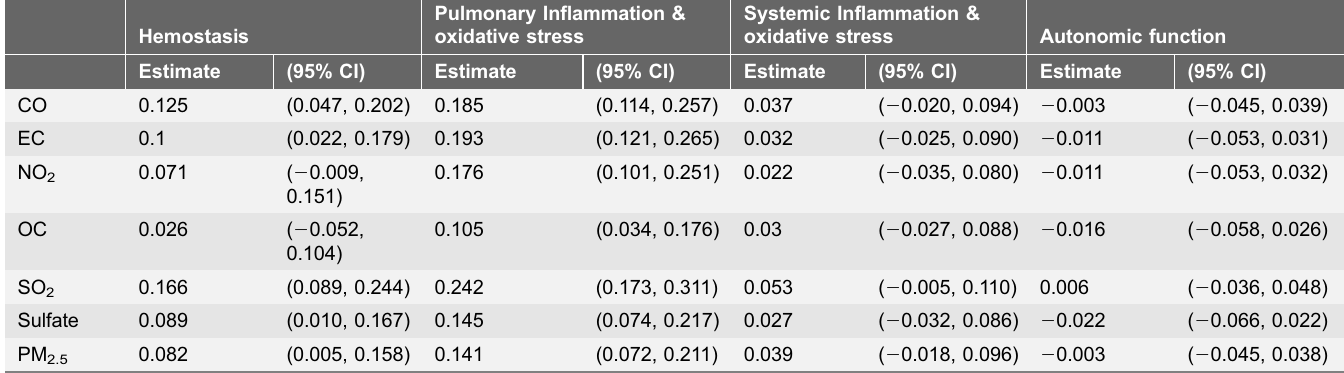
Table 1. Mean association ( ^ b ) between standardized 24 hour average ambient air pollutant concentrations and the average (i.e., biomarker-level random bpl effects are 0), standardized biomarker in each pathway, on the day of assessment (lag 0). Effect sizes are scaled to a 1 standard deviation change in each pollutant.